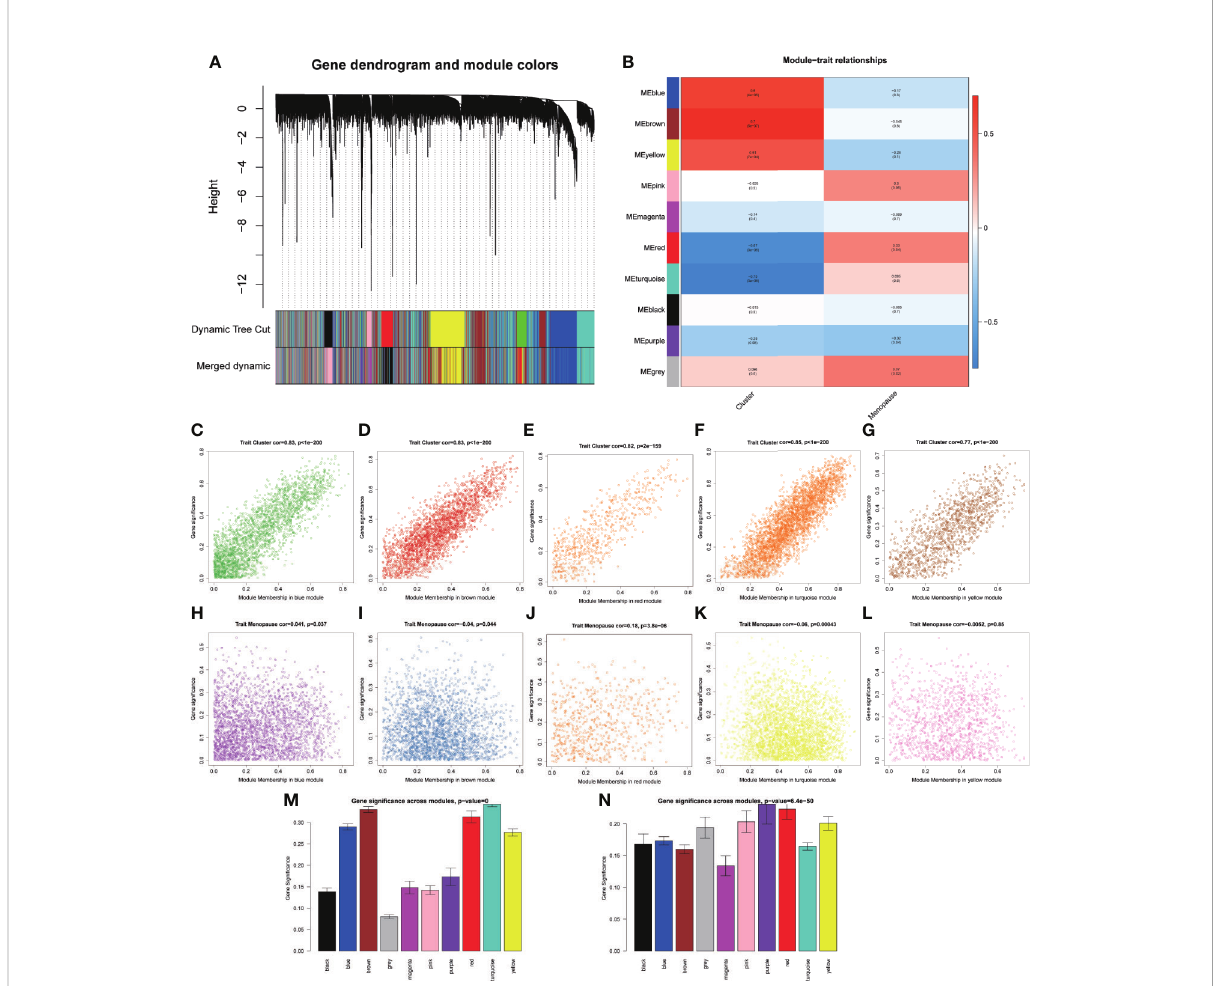
FIGURE 5 Identi fi cation of the OP-related modules by WGCNA. (A) Clustering dendrogram of genes based on the measurement of dissimilarity (1-TOM) together with the assigned module colors. (B) Heatmap showing the correlation between the module eigengenes and clinical traits of OP. (C – G) Scatterplots showing the correlation between the MM and GS in each module (MEblue, MEbrown, MEyellow, MEred, and MEturquoise). (H – L) Scatter plots showing the correlation between the MM and clinical trait (menopause) in each module (MEblue, MEbrown, MEyellow, MEred, and MEturquoise). (M) Bar charts showing the correlation between GS and cluster trait in each module (MEblue, MEbrown, MEyellow, MEred, and MEturquoise). (N) Bar charts showing the correlation between GS and clinical trait (menopause) in each module (MEblue, MEbrown, MEyellow, MEred, and